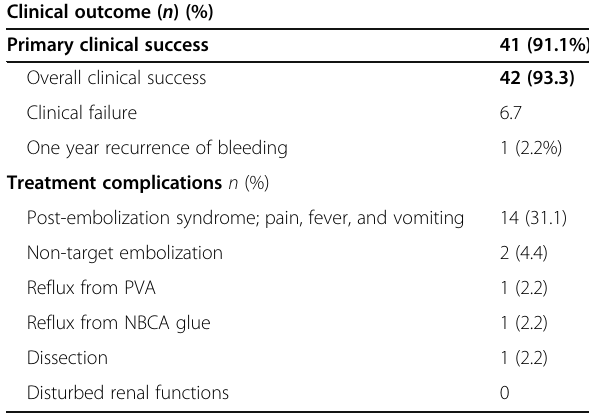
Table 3 Clinical outcome and complications in studied